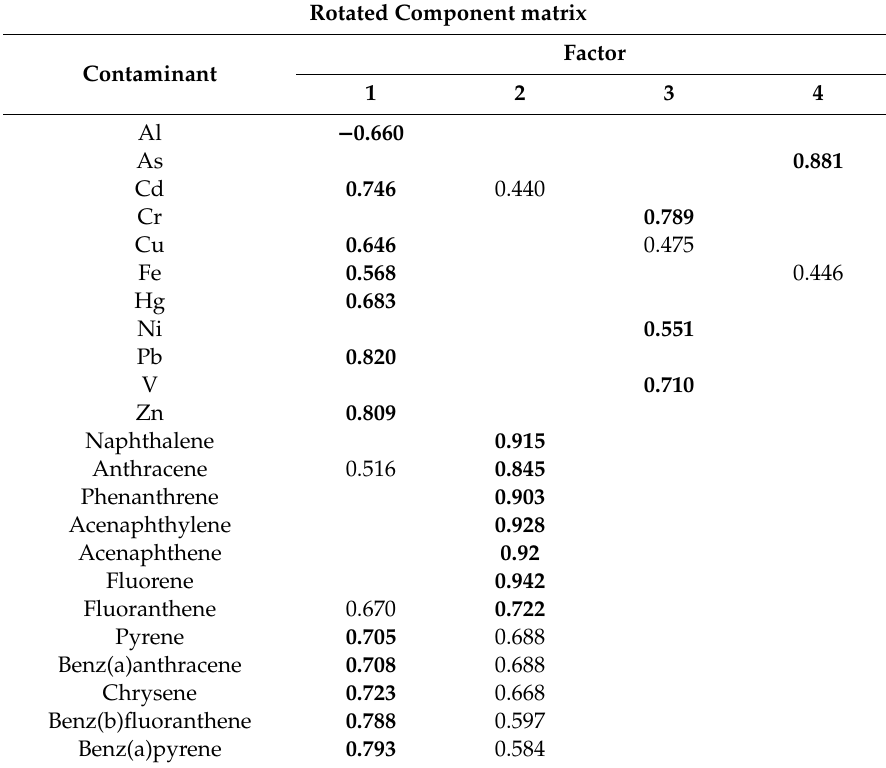
Table 2. Factor loadings matrix: the factor loading values higher than | 0.5 | are highlighted in bold and indicated as the significant loadings for the corresponding factor. Total variance explained by the rotated components (Fs) are